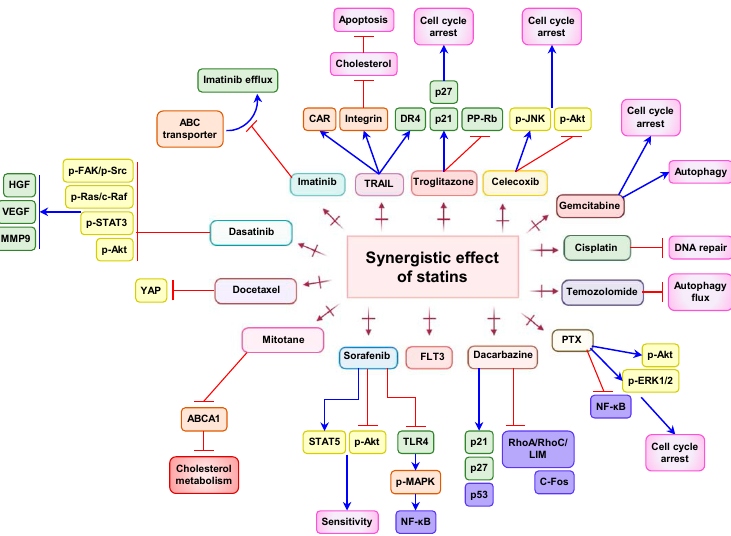
Figure 3. Synergistic action of statins. Statin in combination with anti-cancer drugs such as imatinib, TRAIL, troglitazone, celecoxib, gemcitabine, cisplatin, temozolomide, PTX, dacarbazine, FLT3, sorafenib, mitotane, docetaxel, and dasatinib synergistically suppress and induce signaling cascade leading to cell-cycle arrest, cell death, apoptosis, and sensitivity. Blue arrows indicate upregulation, black colored lines indicate inhibition/suppression, and red arrows indicate the combination of statin with indicated drugs.